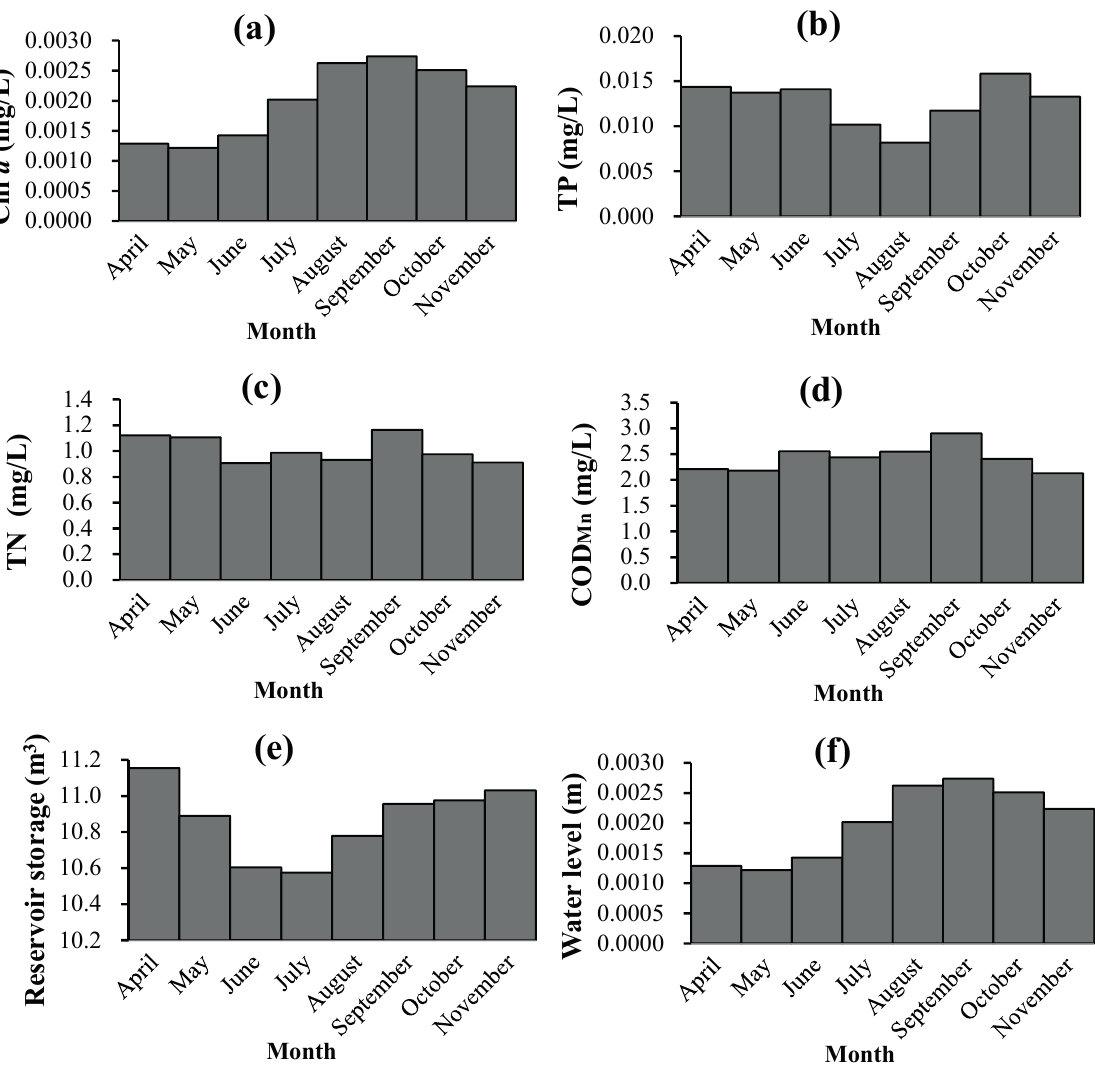
Figure 2. Water environmental situation in Miyun Reservoir: ( a ) Concentration of chlorophyll a ; ( b ) TP concentration; ( c ) TN concentration; ( d ) COD Mn concentration; ( e ) reservoir storage; and ( f ) water